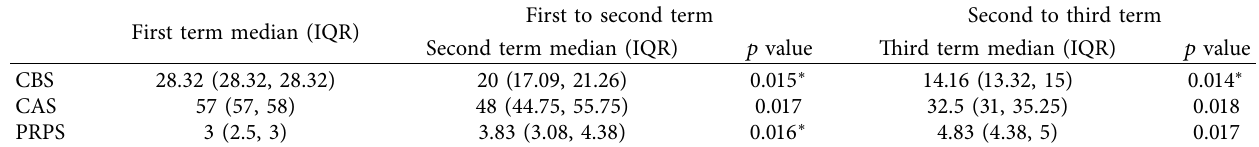
Table 2: Comparison of outcomes in each term.